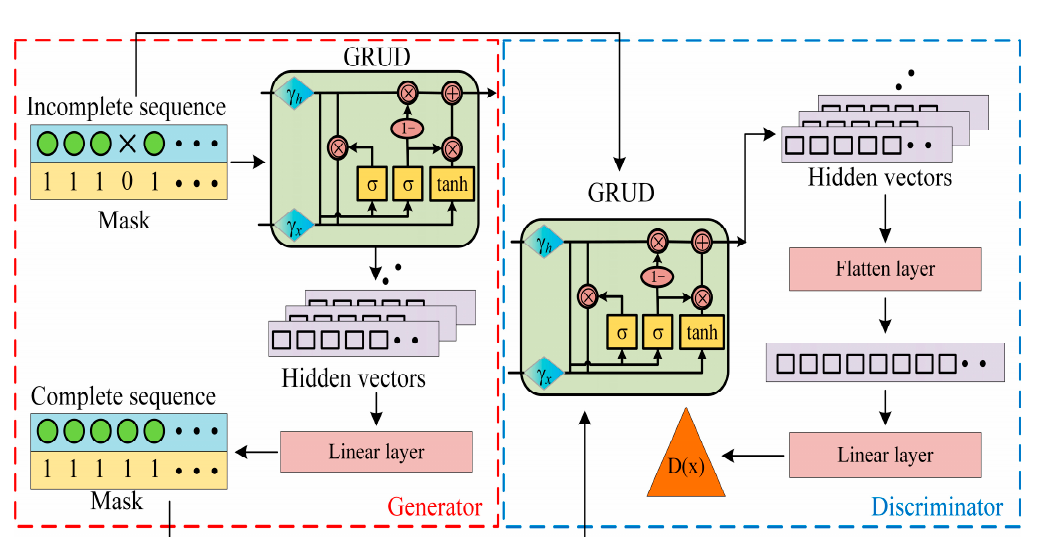
Figure 4. The framework of the proposed GRUD ‐ WGAN.